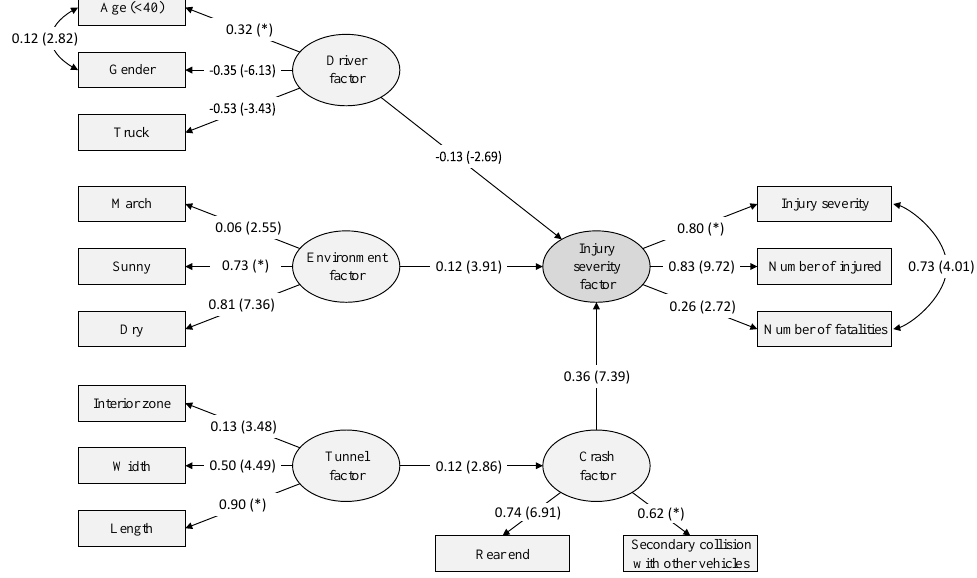
Figure 5. Final SEM for injury severity in freeway tunnel crashes.